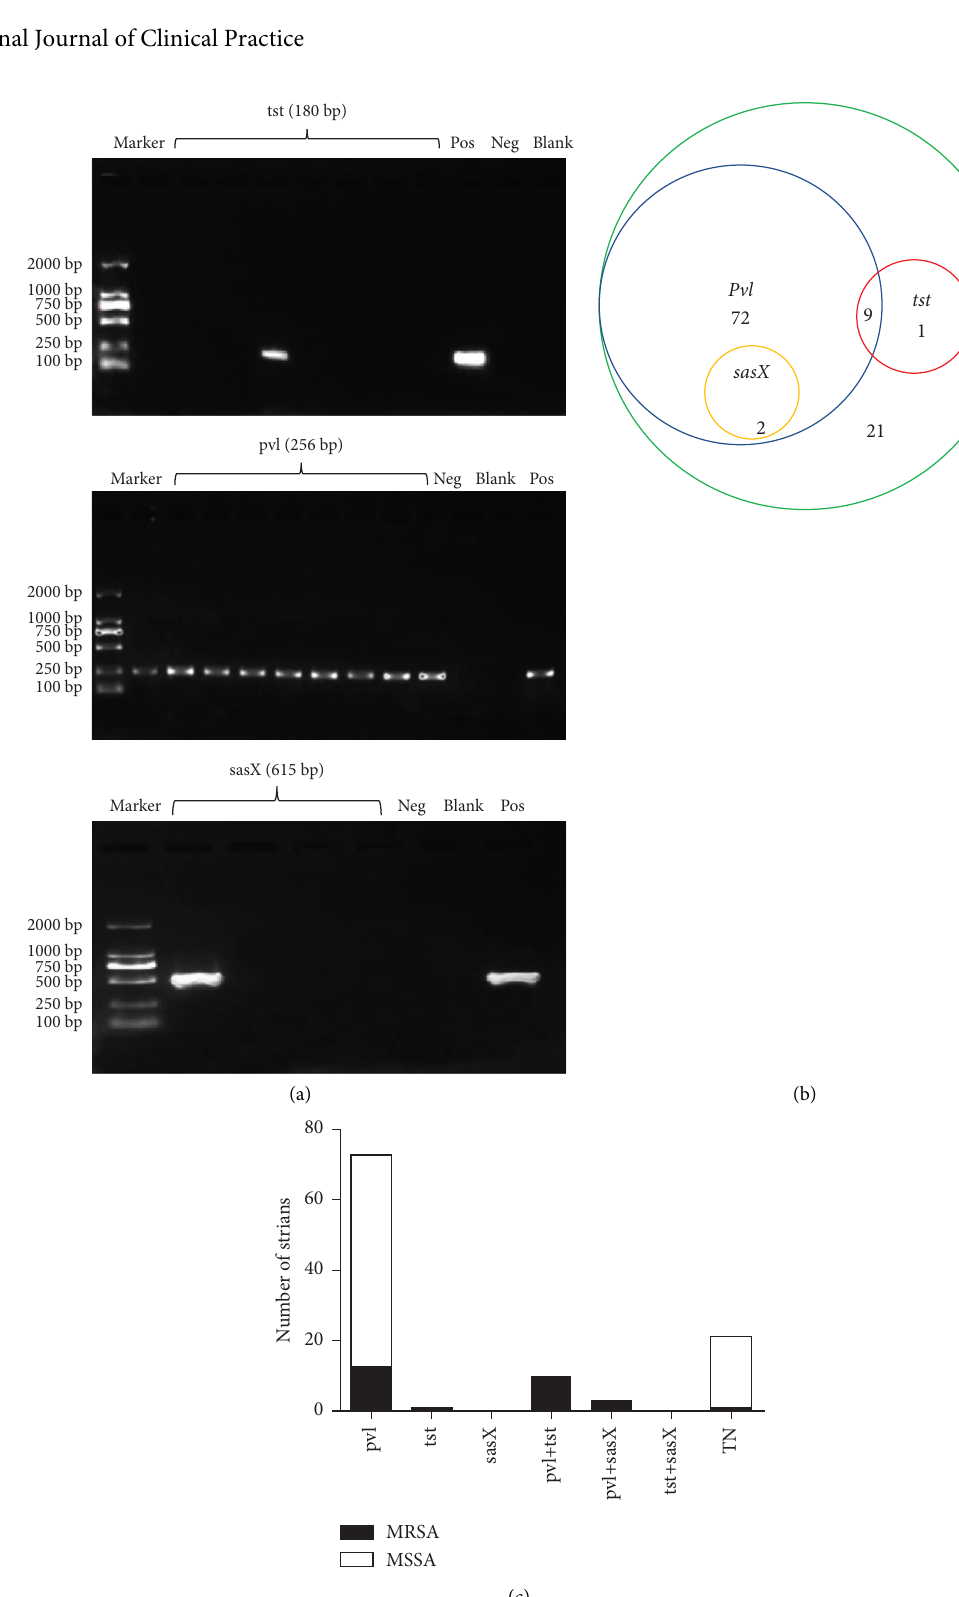
Figure 5: Distribution of virulence factors carried by MRSA and MSSA. (a) Te conventional RT-PCR assay of expression of virulence genes tst , pvl, or sasX. (b) Distribution diagram of virulence genes tst , pvl, and sasX. (c) Histogram of tst , pvl, and sasX distribution of MRSA or